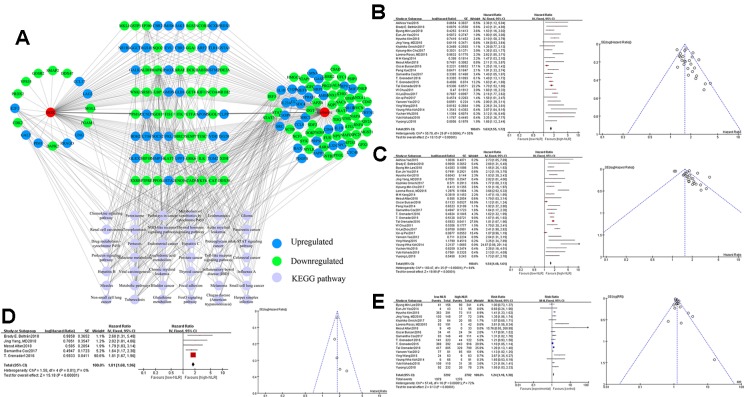
The potential targets of DOX and berberine in regulating neutrophils analyzed by network pharmacology and a predictive role of neutrophil to lymphocyte ratio (NLR) in chemotherapy sensitivity of cancer patients. (A) The potential targets of DOX and berberine in regulating neutrophils. (B) Effect of NLR on progression-free survival (PFS) in cancer patients receiving chemotherapy in the meta-analysis shown as the forest map and the funnel diagram. (C) Effect of NLR on OS in cancer patients receiving chemotherapy in the meta-analysis shown as the forest map and the funnel diagram. (D) Effect of NLR on overall survival (OS) in cancer patients receiving combination chemotherapy in the meta-analysis shown as the forest map and the funnel diagram. (E) Effect of NLR on adverse effects in cancer patients receiving chemotherapy in the meta-analysis shown as the forest map and the funnel diagram. DOX, doxorubicin.